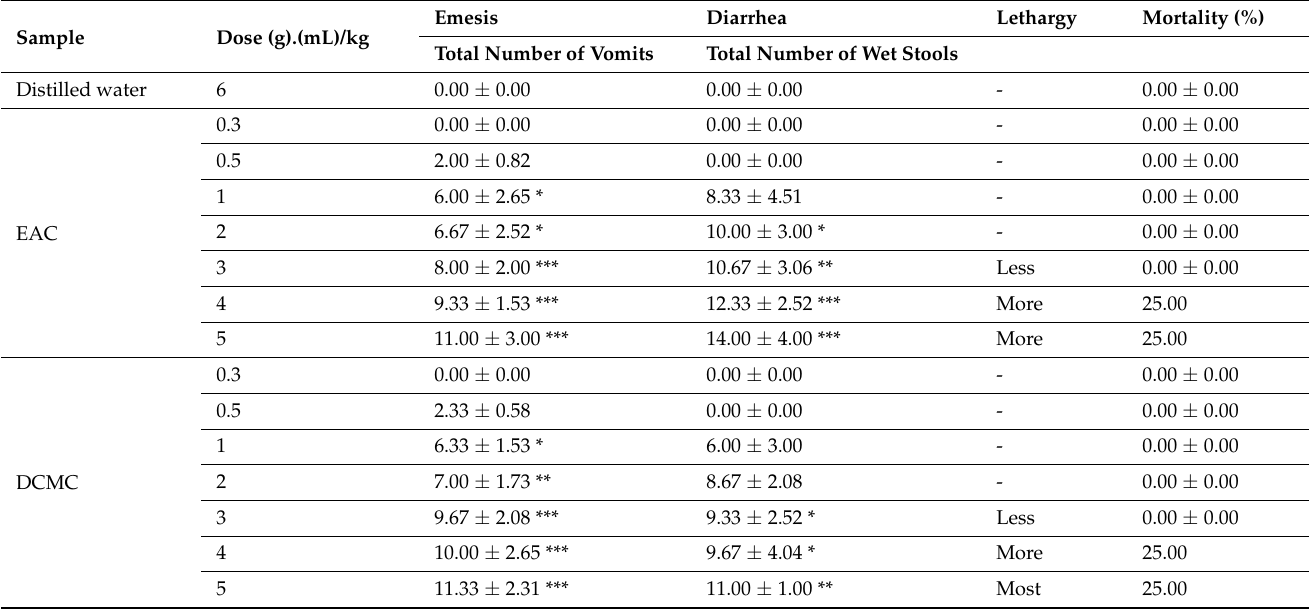
Table 4. Acute toxicity of the ethyl acetate and dichloromethane fractions of Chrozophora tinctoria in